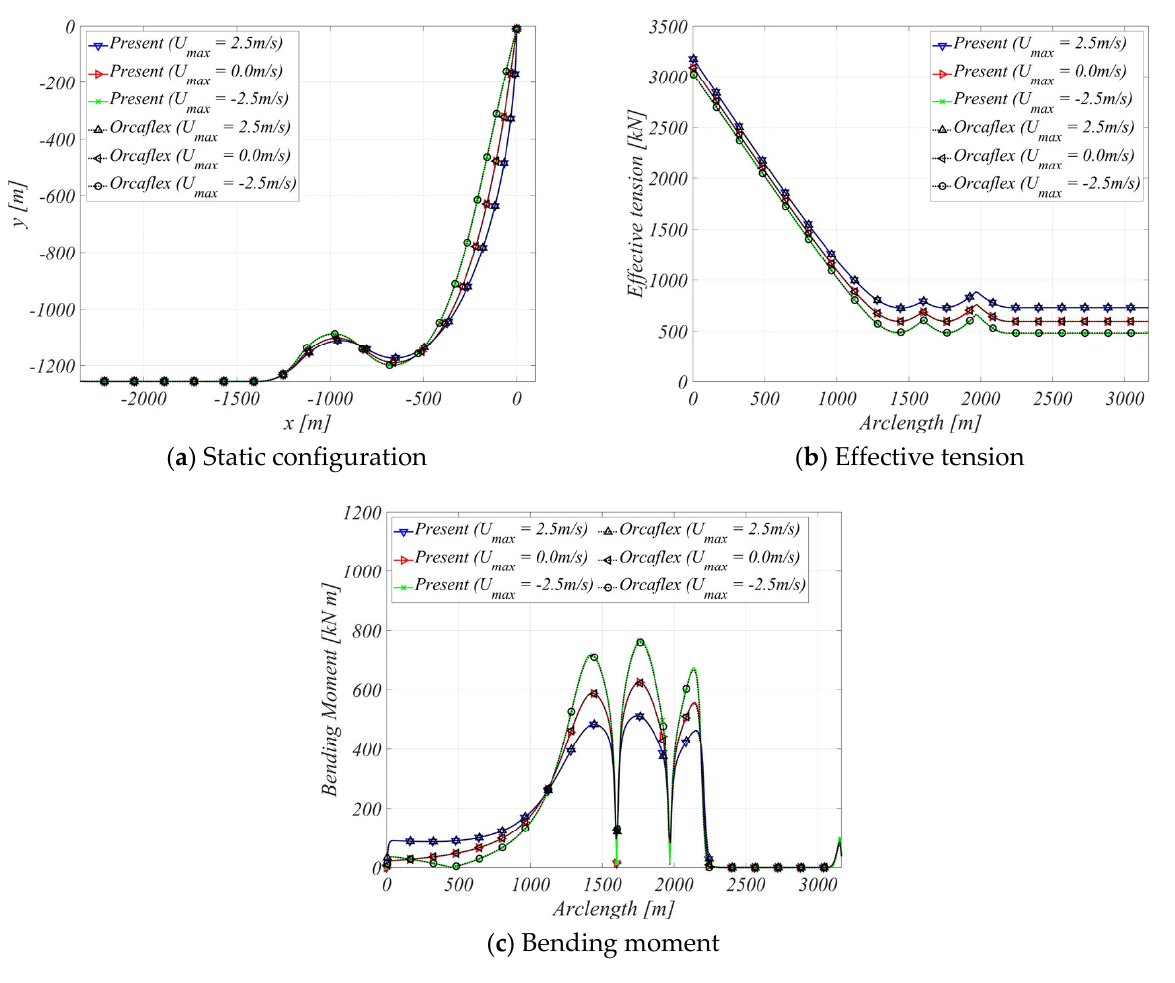
Figure 11. Static configuration of steel lazy wave riser with various shear current.